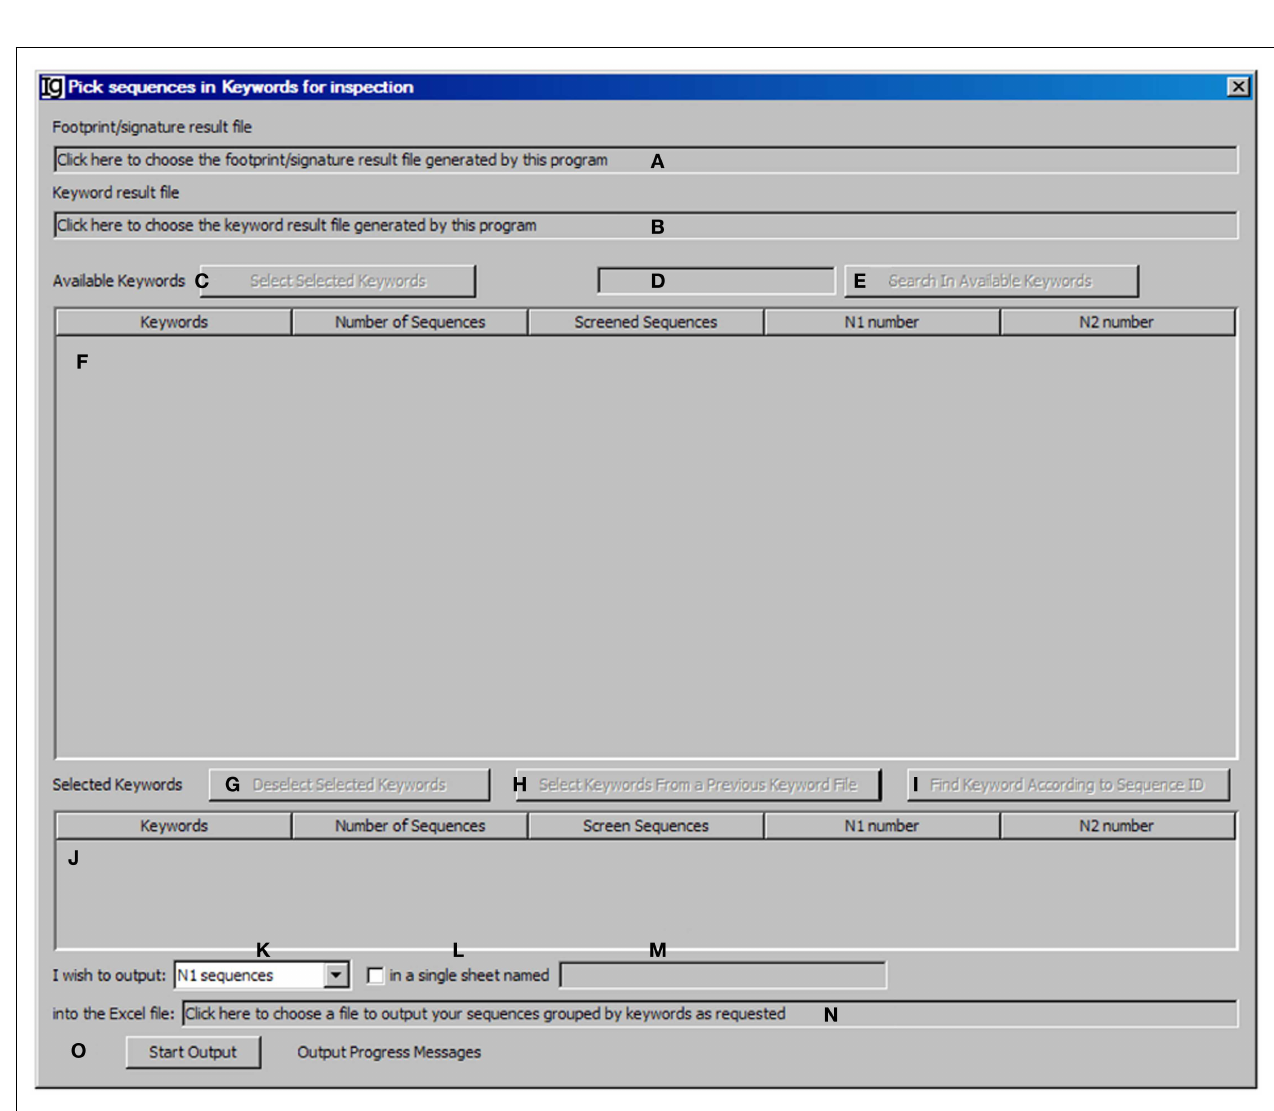
keyword analysis result file so that keywords can be isolated, to repeat a previous pick. (I) Button to select keywords associated with entered GenBank ID. (J) Window area displaying the selected keywords. (K) Combo box to select the type of sequences to output. (L) Checkbox to indicate intention to (O) Button to start the pick/isolation